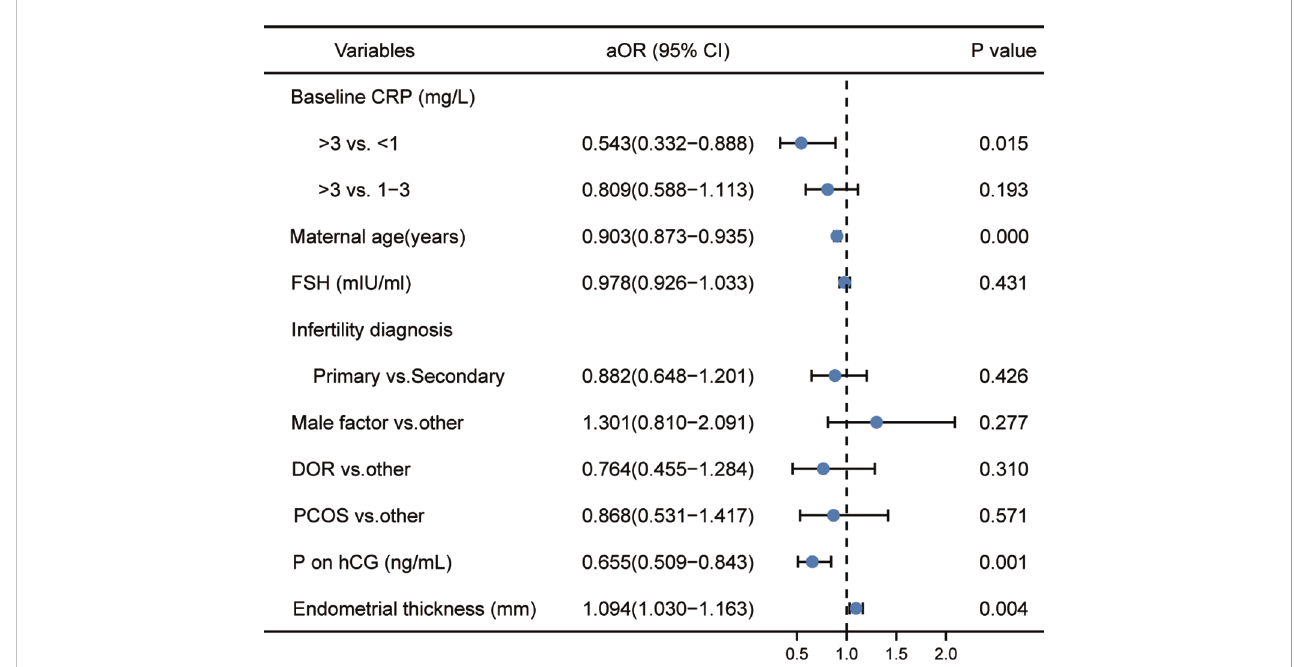
FIGURE 2 Logistic regression analysis of potential factors associated with live birth rate. ‘ aOR ’ indicates that the odds ratio (OR) and 95% CI were adjusted for potential confounding